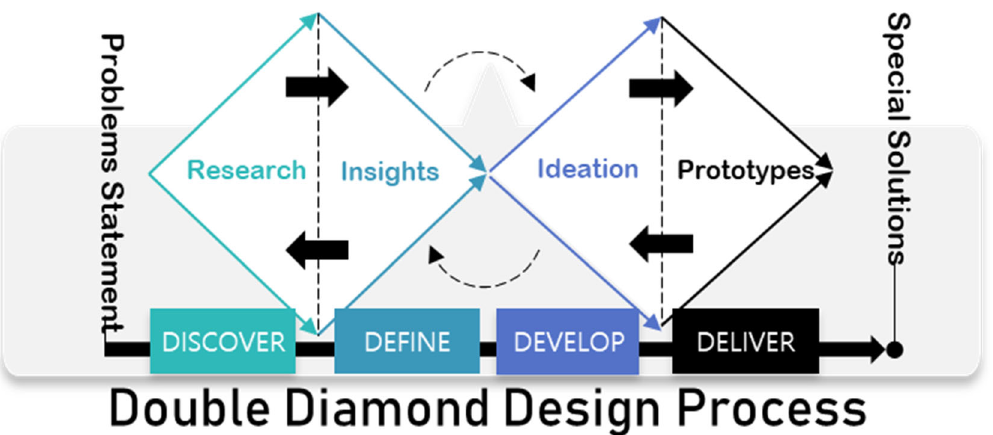
Figure 1. Double diamond design process .